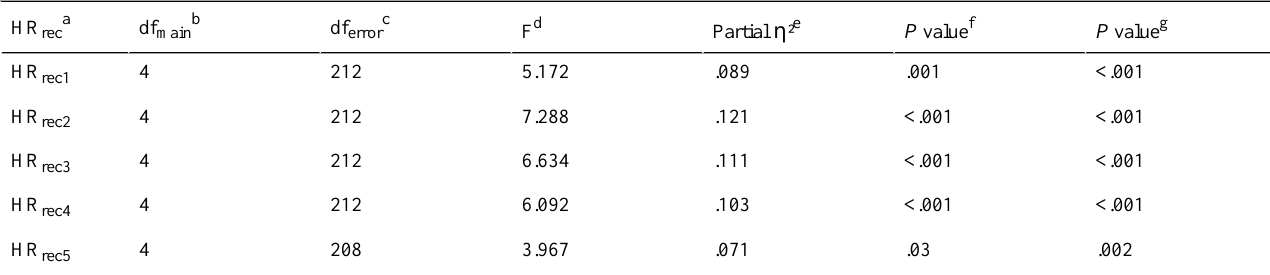
Table 2. Results from the two-way, mixed-model, analysis of variance (ANOVA) for the heart rate recovery (HRrec) during the first 5 minutes after the 6-minute walking test